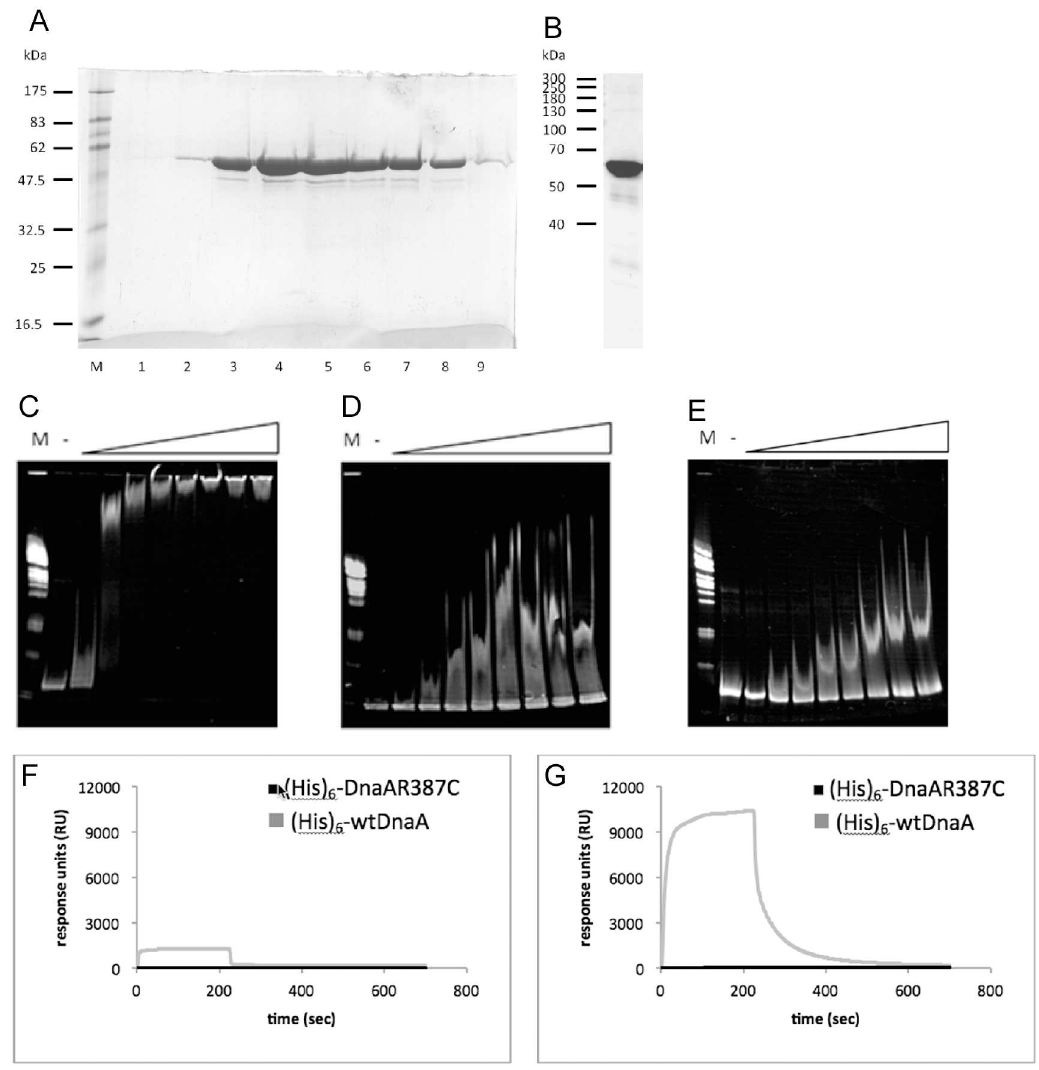
Fig 3. Biochemistry of DnaA. A) Coomassie-stained SDS PAGE showingthe purificationof DnaA by gel filtration chromatography followingnickel NTA affinity chromatography; shown are peak elution fractions. B) Western blot analysisusing anti DnaA antiserum of purifiedDnaA, showingthat lower bands in gel from panel A) are DnaA degradationproducts. C) EMSA (ethidium-bromide stained 4–12%gradientacrylamidegels) of wild type DnaA binding to a 624 bp fragment containing oriC (0.9 pmol). M = marker,— = no protein, followinglanes increasing amounts of DnaA, of 2, 4, 8, 16, 20, 40, 60 and 80 pmol. D) EMSA of wild type DnaA bindingto a 532 bp fragment not containing dnaA boxes, same as panelC). E) EMSA of DnaAR387Cbindingto a 624 bp oriC DNA fragment, same as panel D). F) Surface plasmon resonance [SPR] experiments with DnaAR387C[2.5 μ M] bindingto double-biotinylated[5 0 and 3 0 ends] 624 bp oriC -DNA[0.25 pmol] that is bound to a streptavidin coated sensor chip surface. The protein sample [75 μ l] was loadedto the chip at a flow rate of 20 μ l/min, i.e. for 225 seconds, followedby protein dissociationfrom the DNA. Protein-DNA interactions were measuredas response units [RU] in real time over a periodof 700 seconds. All values represent the difference of absolutemeasuredresponseunits that have been subtracted from unspecificbindingevents in a control flow chamber. Black line: DnaAR387C, grey line: wtDnaA. G) SPR in the presence of 2.5 mM ATP.